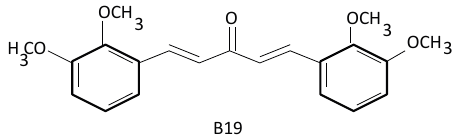
Figure 3. Structure of a mono-carbonyl analogue of curcumin